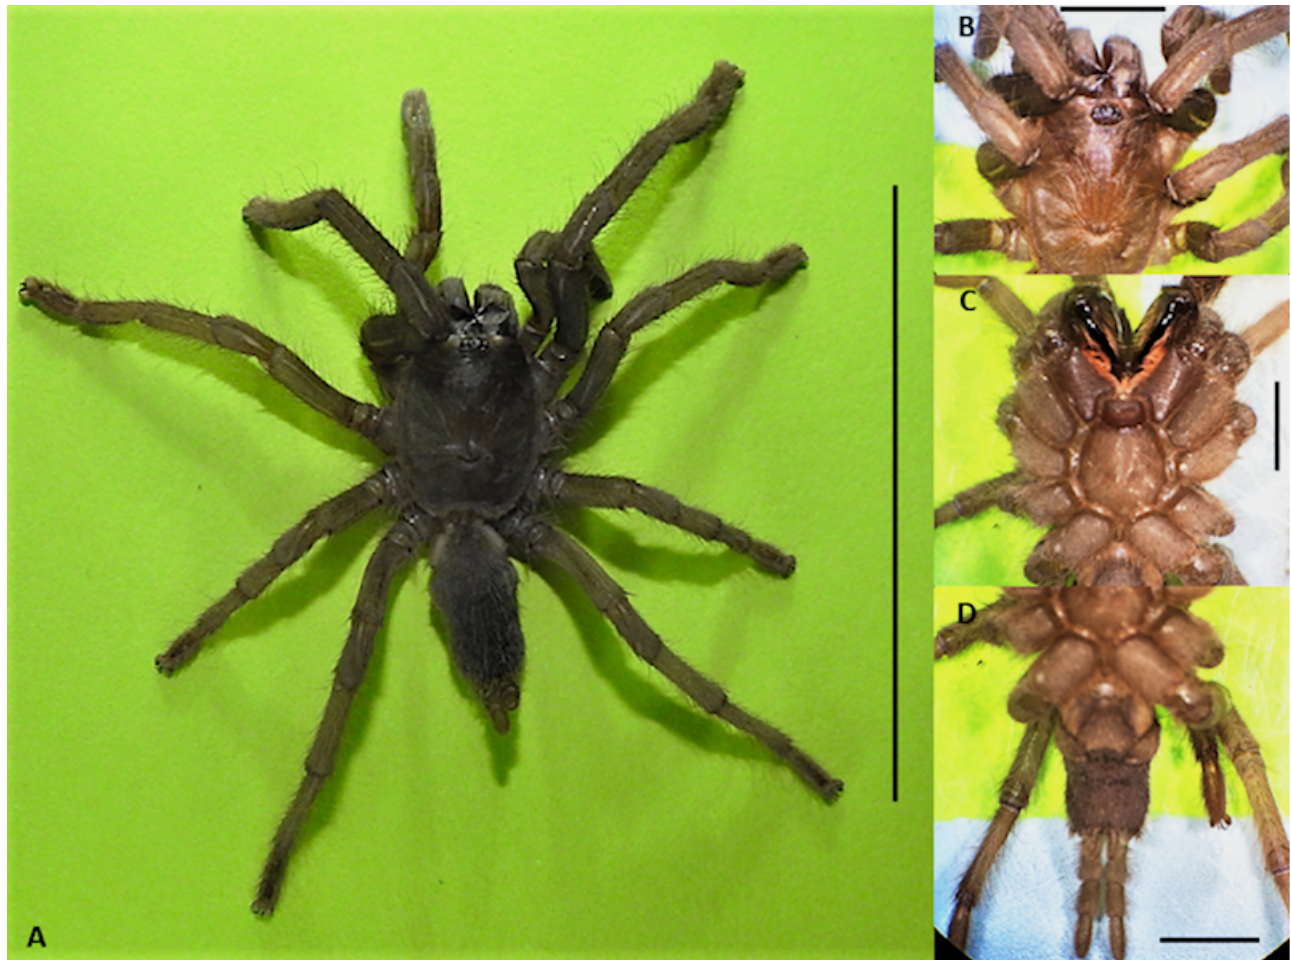
Figure 1. A sample of Phlogiellus bundokalbo that is used for venom collection and taxonomic identification. (A) Dorsal view, habitus, Bagacay, Surigao Island, Province of Surigao del Norte, Mindanao, Philippines. (B) Carapace and eyes, dorsal view. (C) Sternum, labium, maxilla, and coxae, ventral view. (D) Abdomen, ventral view. Scale bar – 30 mm for (A) and 5 mm for (B) , (C) , and (D)